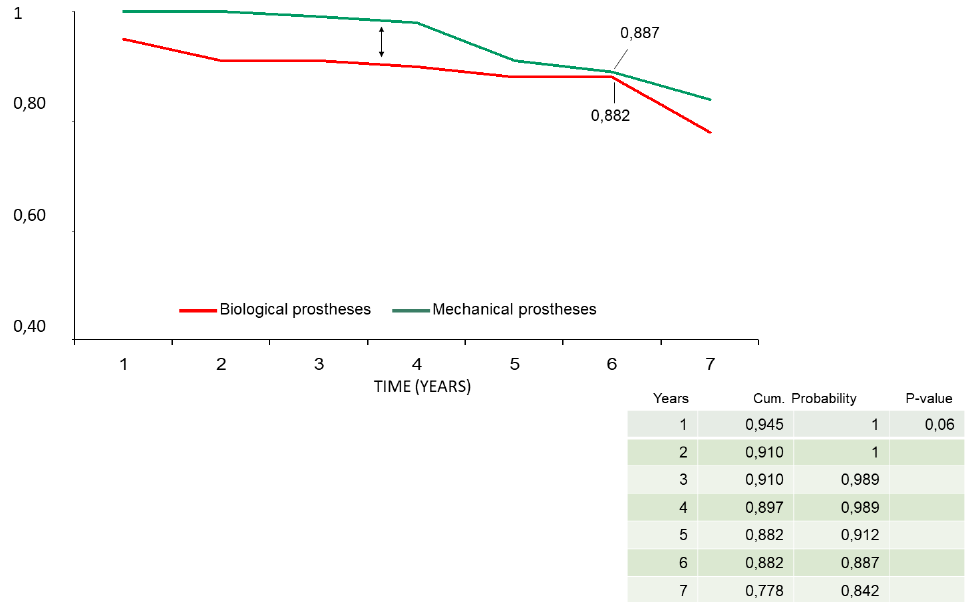
Figure 7. Event-free survival stratified by biological vs. mechanical prostheses valved conduits (Mantel–Cox test).